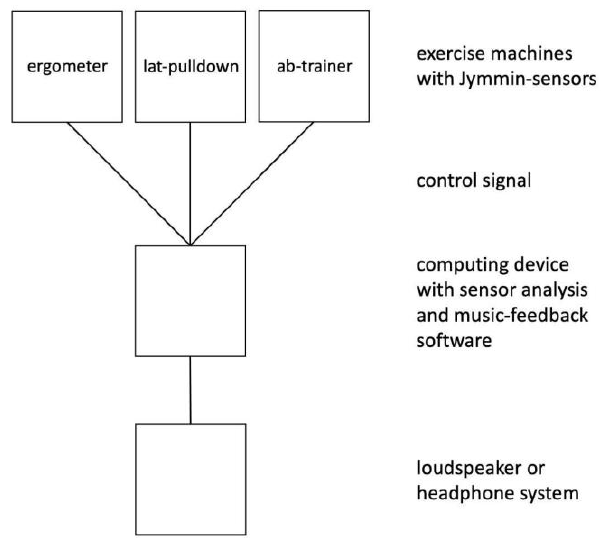
Figure 1. Jymmin